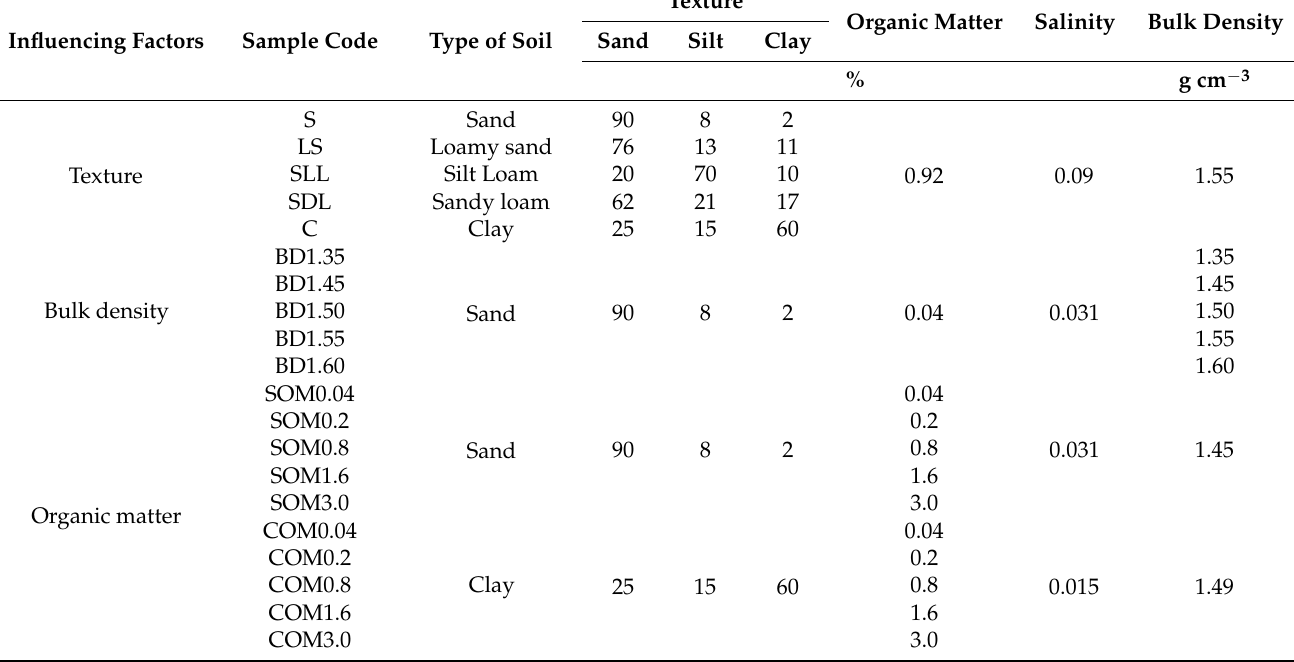
Table 2. Soil samples for evaluating the factors influencing the Campbell